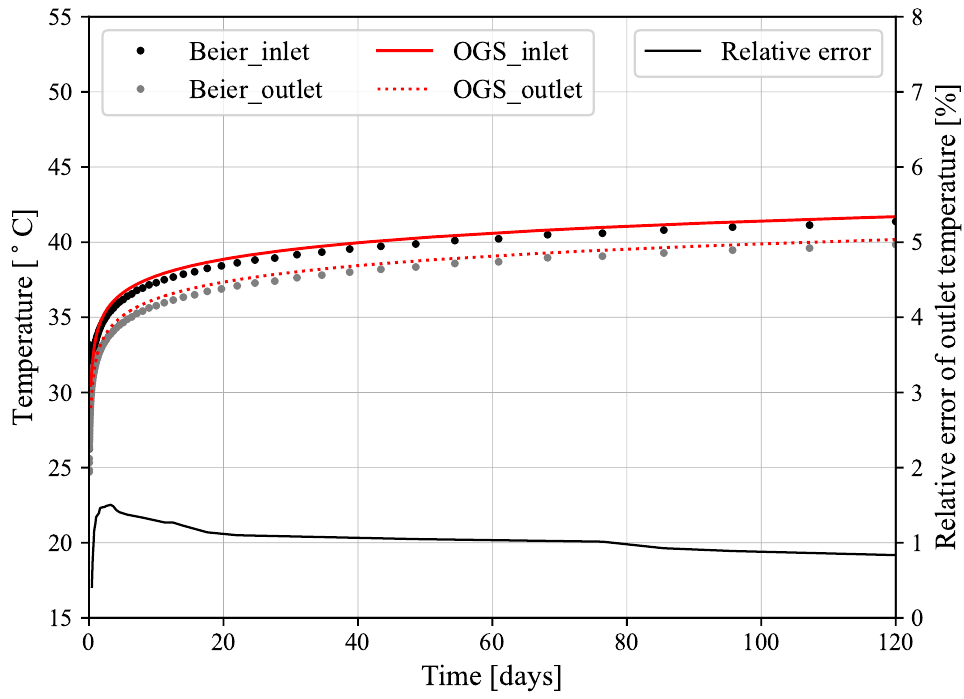
Figure 2. Verification of proposed MSBHE model based on OpenGeoSys against Beier’s analytical